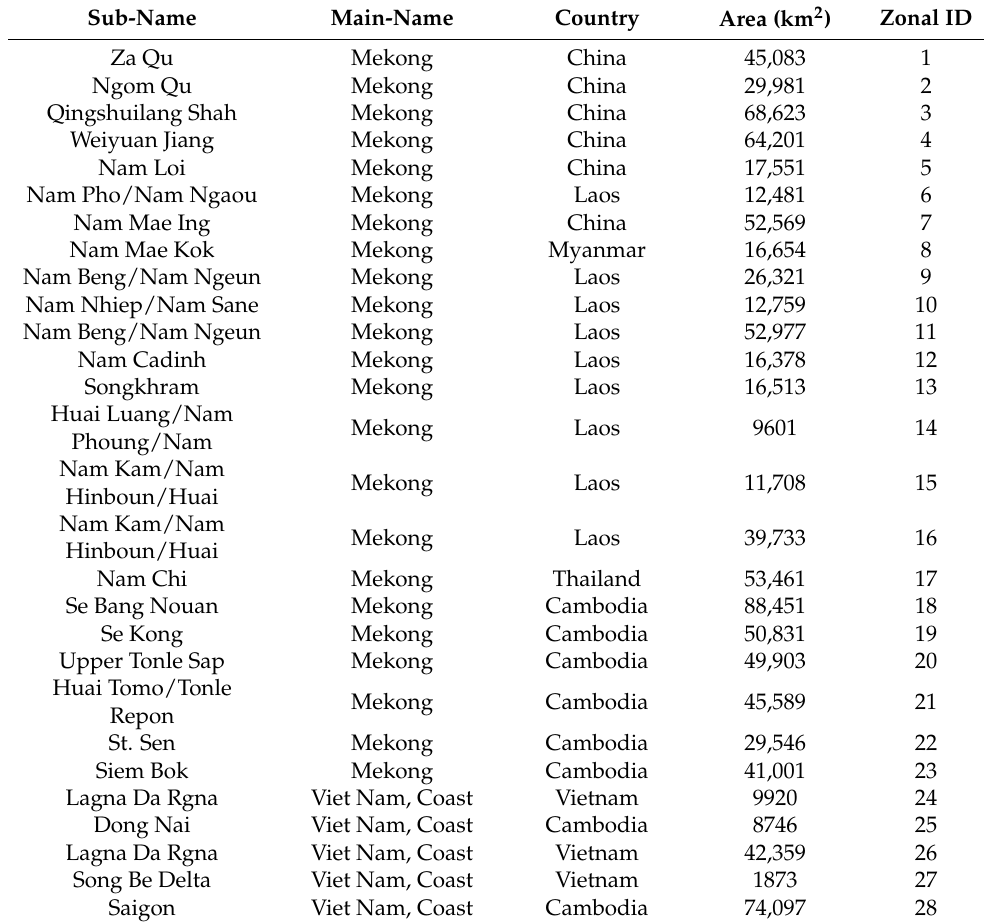
Table 1. Mekong zones classified by ecological characteristics by Gassert et al.